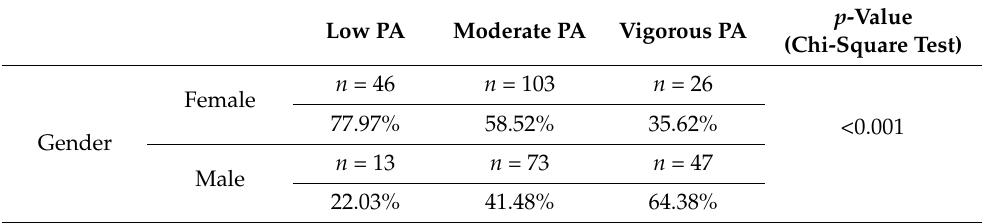
Table 2. Level of physical activity according to gender.